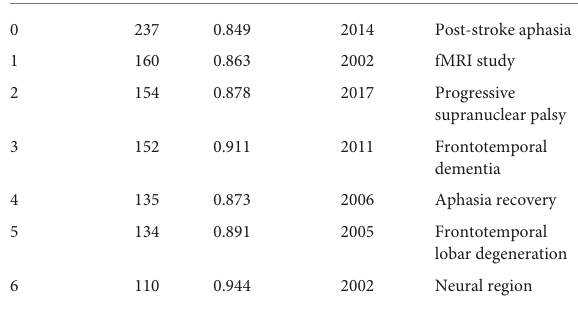
TABLE 3 Major clusters of co-cited